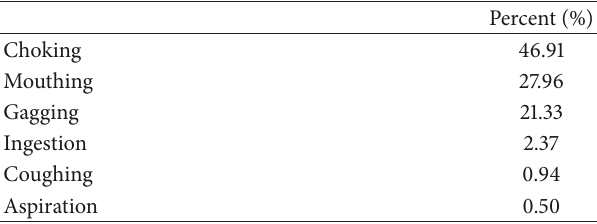
Table 1: Type and occurrence of choking